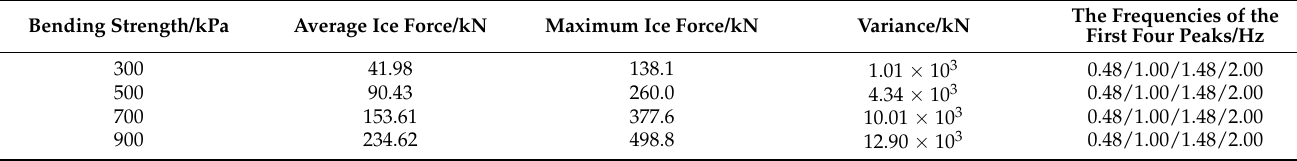
Figure 21. Change trend of variance and ice force with bending strength ( σ f ).